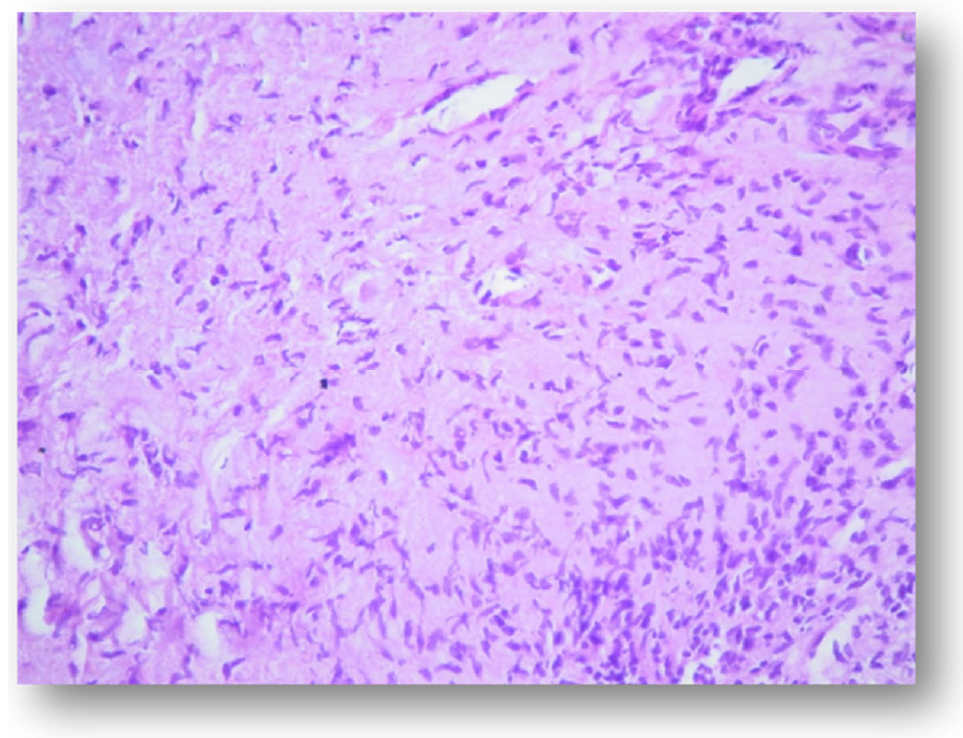
Figure 8. Coronal dental pulp aspect of a 67 year old female, type 2 diabetes, HE staining x200.